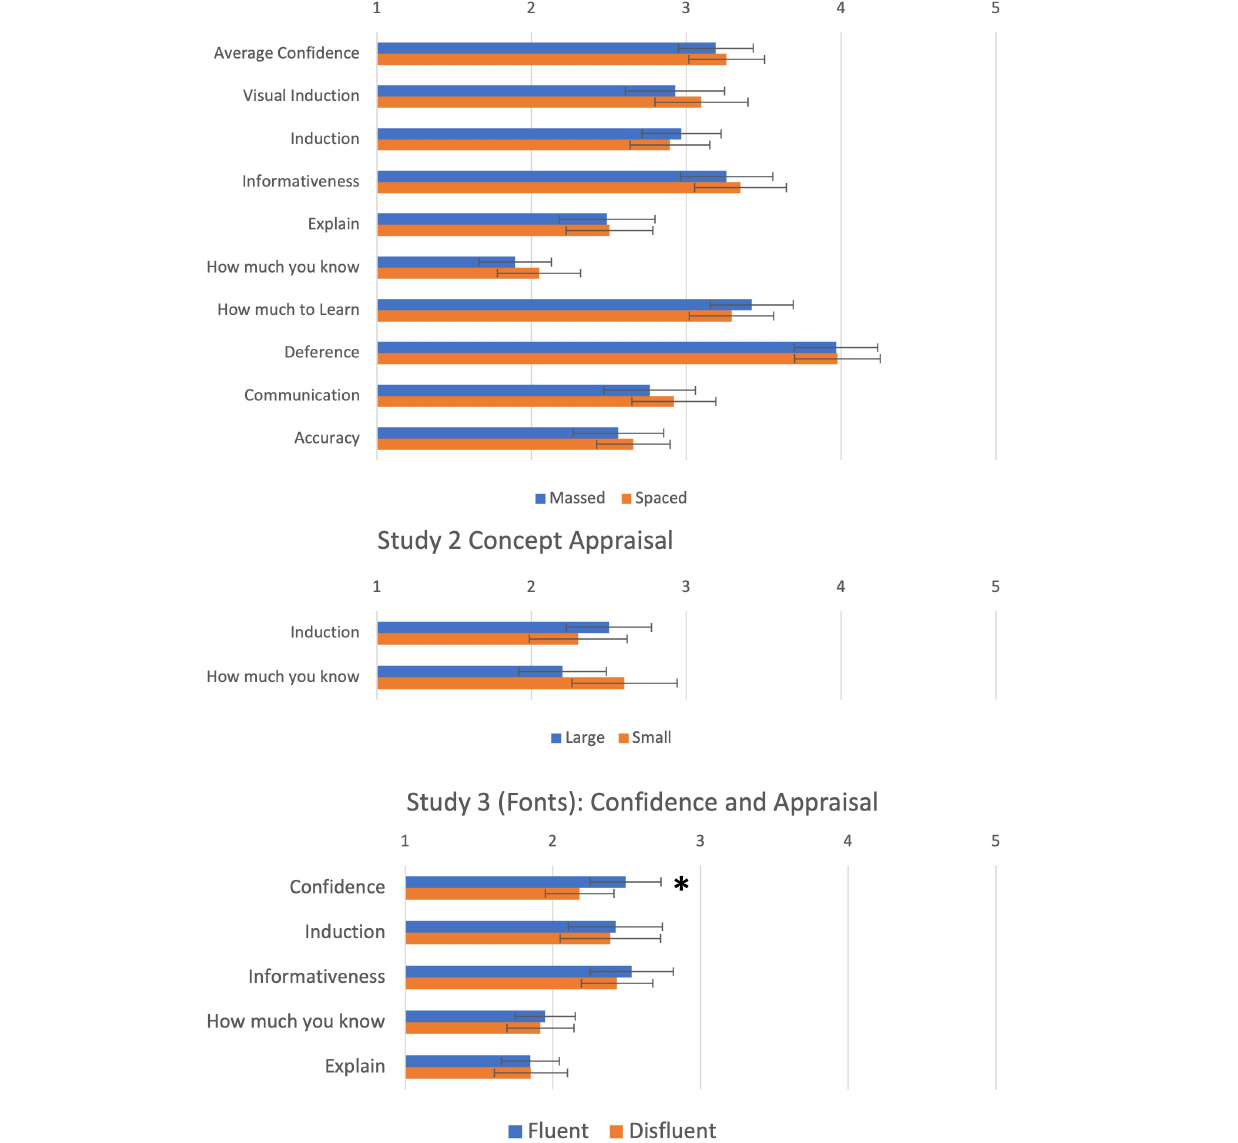
FIGURE 2 | Average confidence at test, and concept appraisal for Studies 1–3. ∗ Significant at p < 0.05.